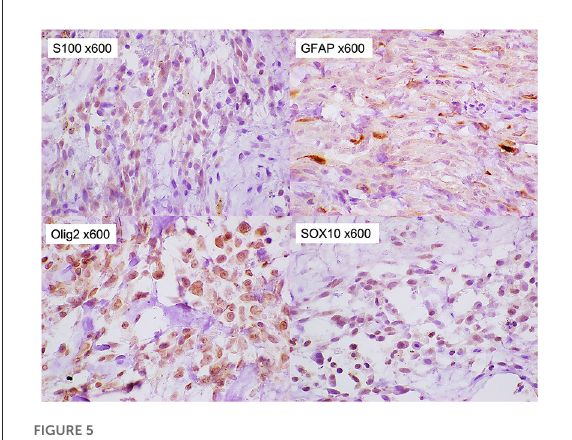
FIGURE5 Immunohistochemical staining of the tumor. The tumor cells were stained positively for S-100, glial fibrillary acidic proteins, Olig-2, and SOX10 (x 600).